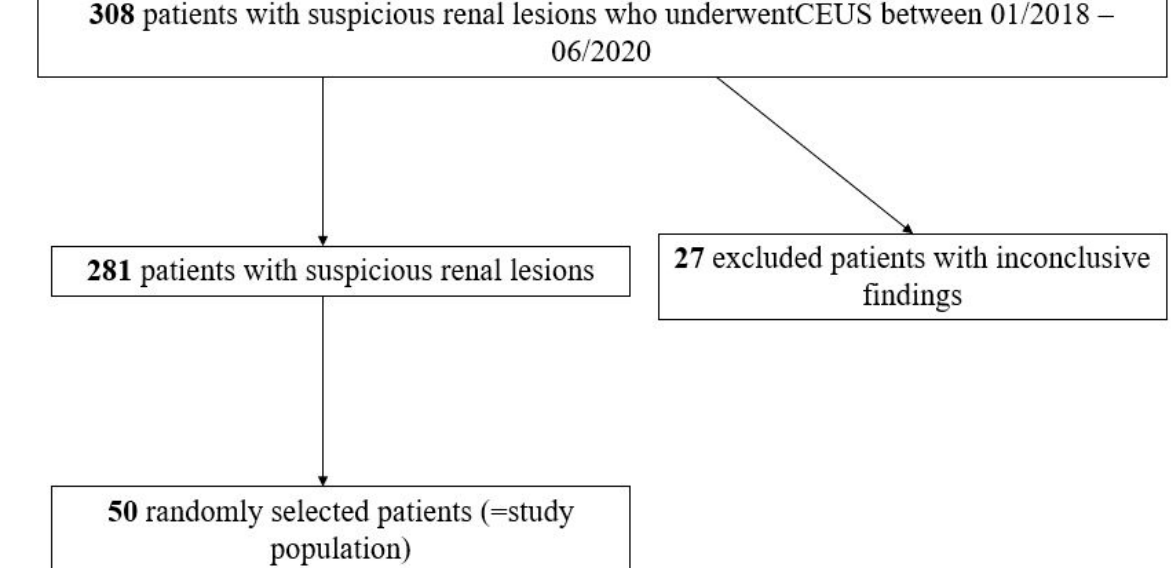
Figure 1. Flowchart illustrating the included patients with suspicious renal lesions who underwent contrast-enhanced ultrasound (CEUS) for further characterization and excluded patients.